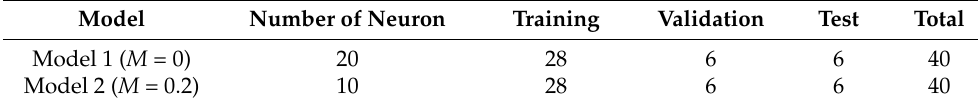
Table 10. Information about the data set used in each ANN model and the number of neurons. Model Number of Neuron Training Validation Test Total Model 1 ( M = 0) 20 28 40 Model 2 ( M =